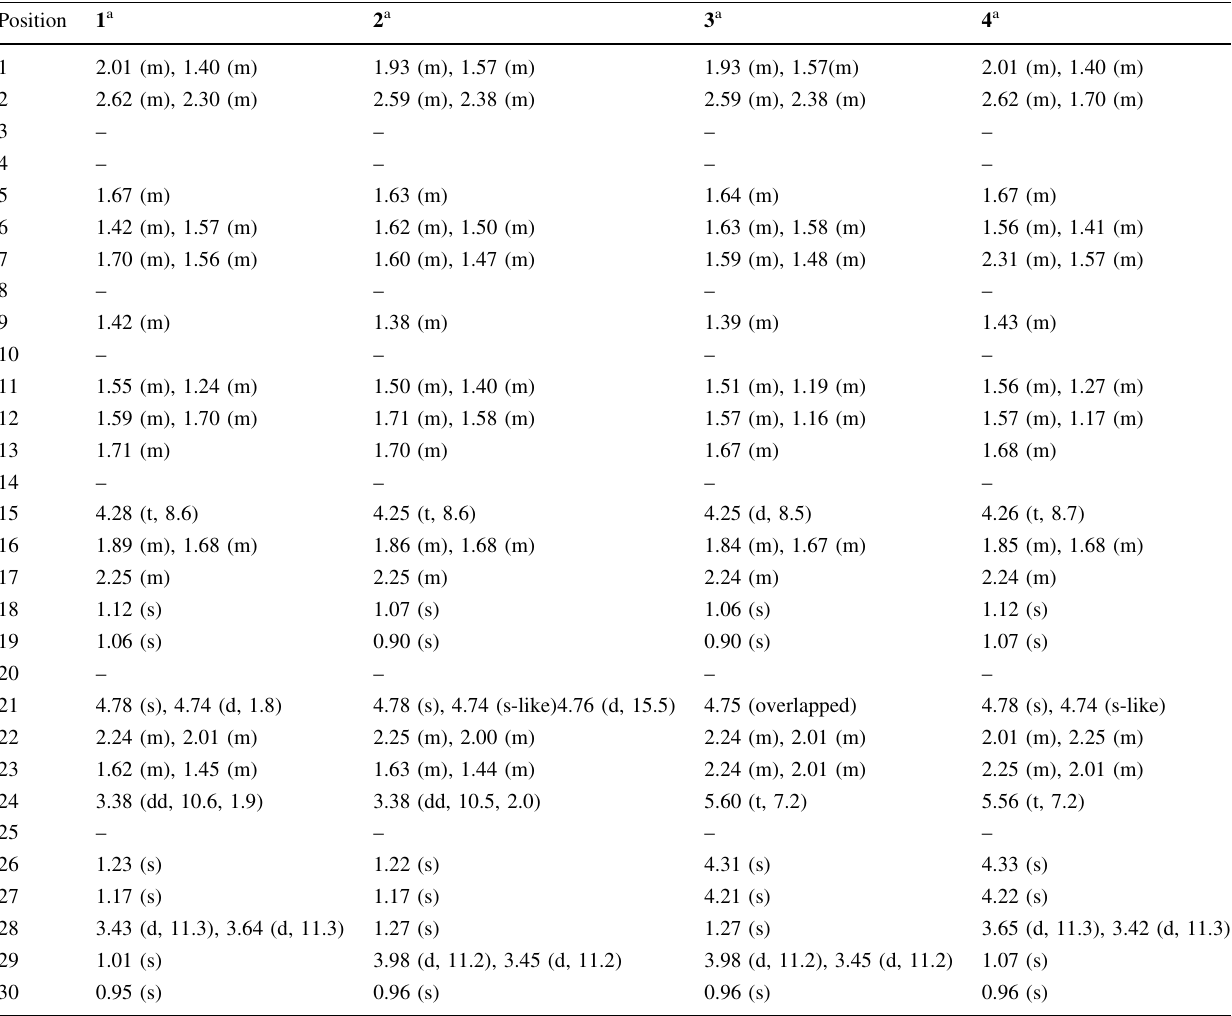
Table 1 1 H NMR spectroscopic data of compounds 1 – 4 [ d in ppm, J in Hz]